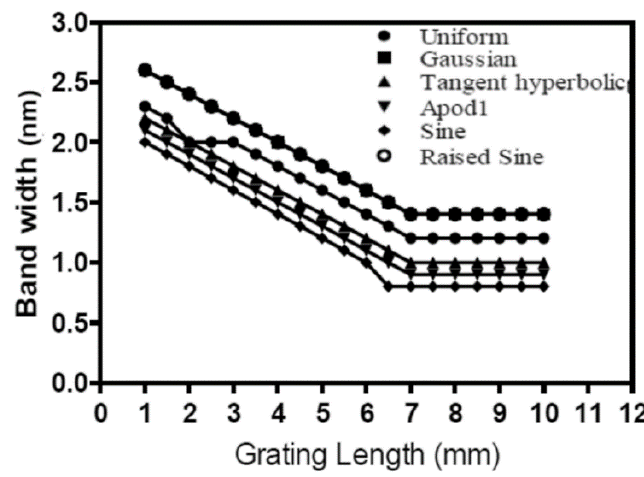
Figure 11. Relationship between FBG sensor bandwidth and grating length [16].